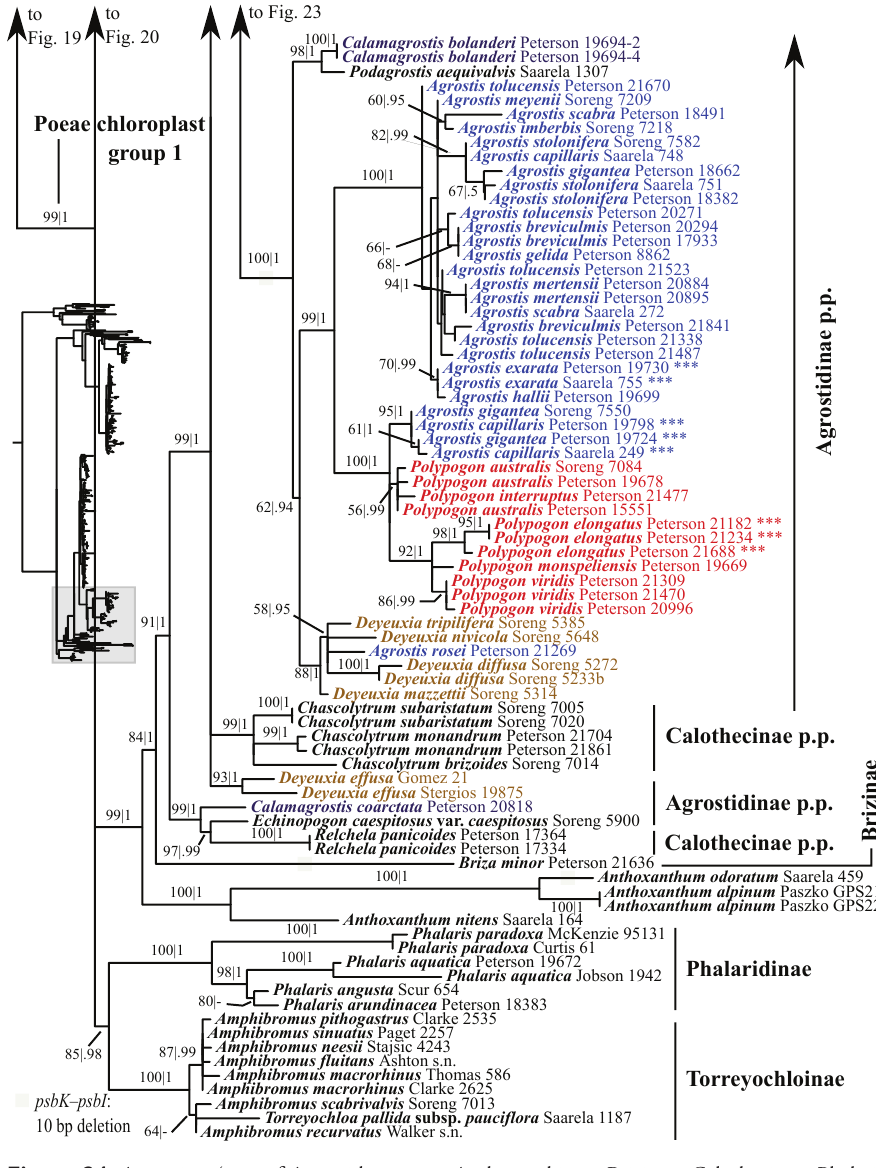
Figure 24. A portion (part of Agrostidinae p.p., Anthoxanthinae, Brizinae, Calothecinae, Phalaridin- ae and Torreyochloinae) of the maximum likelihood phylogram inferred from combined plastid data ( atpF–atpH , psbK–psbI , psbA–rps19–trnH , matK , trnL–trnF ). ML bootstrap support (left) and BI poster probabilities (right) are recorded along branches. A dash indicates posterior probability <.5. No support is shown for branches with bootstrap support <50% and posterior probability <.5. The shaded area of the smaller tree on the left indicates the location in the overall tree of the portion shown. Placements of samples with asterisks (***) are incongruent in nrDNA and plastid trees. An indel in psbK–psbI is mapped onto the